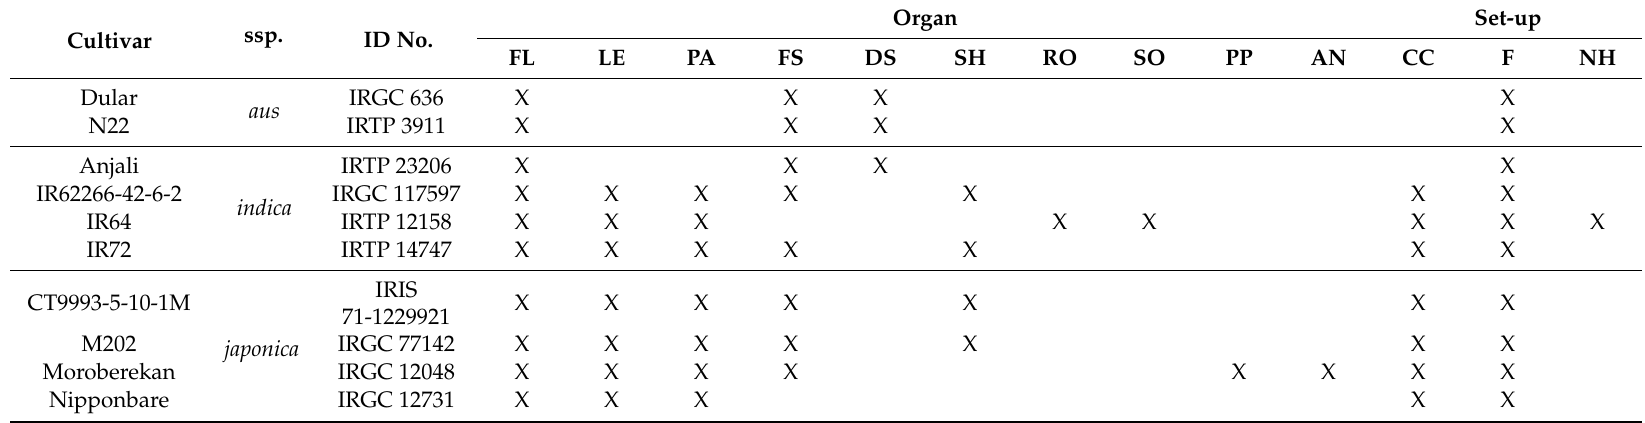
Table 1. Sampling for PacBio isoform sequencing. RNA of ten Oryza sativa L. ( Poaceae ) cultivars from di ff erent organs and conditions was extracted and pooled for each cultivar (FL—flag leaves, LE—leaves, PA—panicles, FS—flowering spikelets, DS—developing seeds, SH—sheaths, RO—roots, SO-shoots, PP—pollinated pistils, AN—anthers). Seed database accession numbers (IRTP / IRGC / IRIS ID No.) from the International Rice Research Institute (IRRI) are shown. Plants were grown in climate chambers (CC), net-houses (NH), and / or in the field (F). Cultivars were sorted alphabetically within the subspecies (ssp.) aus , indica , and japonica . See Supplementary File S1 for a more detailed description of all samples used for RNA isolation. X—sample was taken for the respective organ and